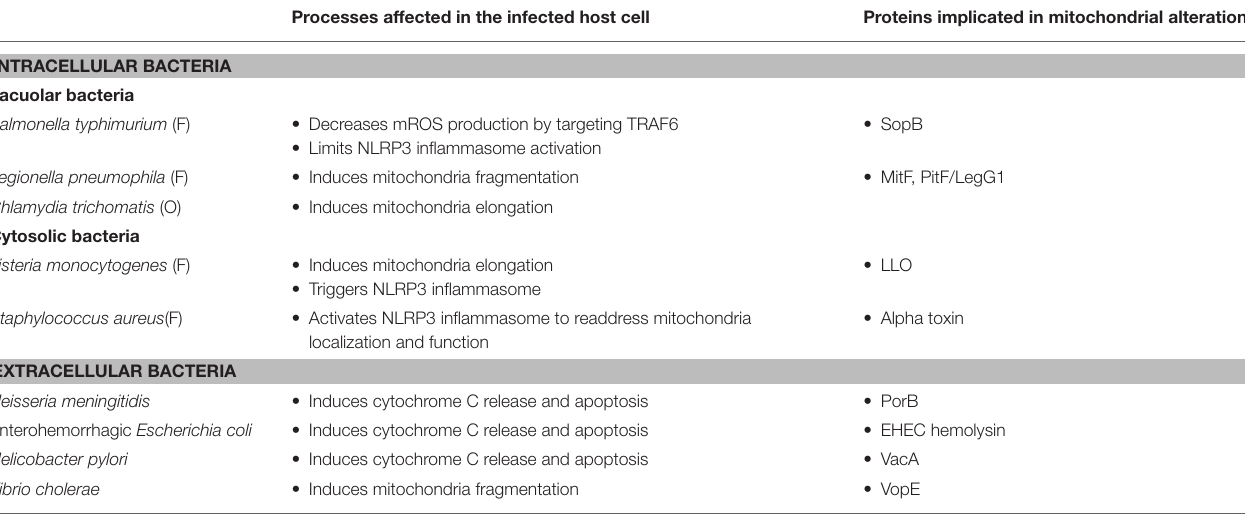
TABLE 1 | Intracellular and extracellular pathogens that impact mitochondrial dynamics. Processes affected in the infected host cell Proteins implicated in mitochondrial